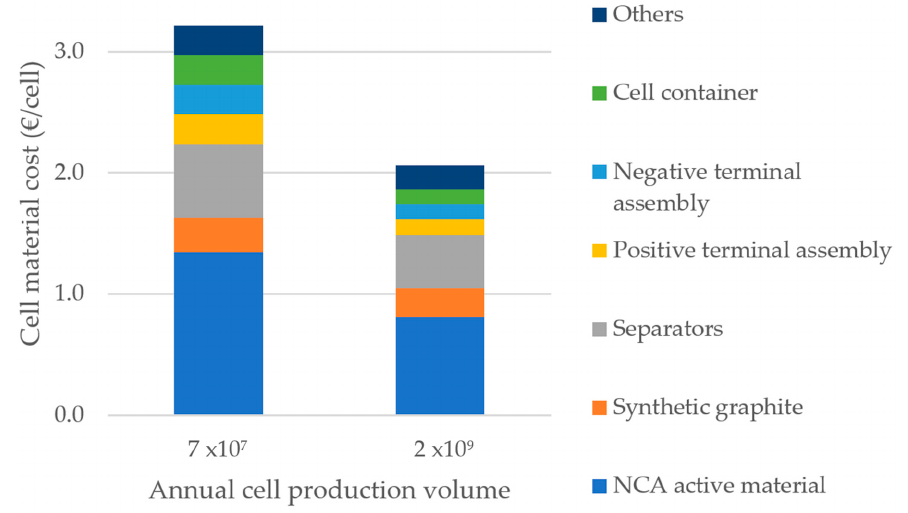
Figure 4. Cell material cost for cells manufactured in Korea, with an average cathode active material price of 33 $/kg.